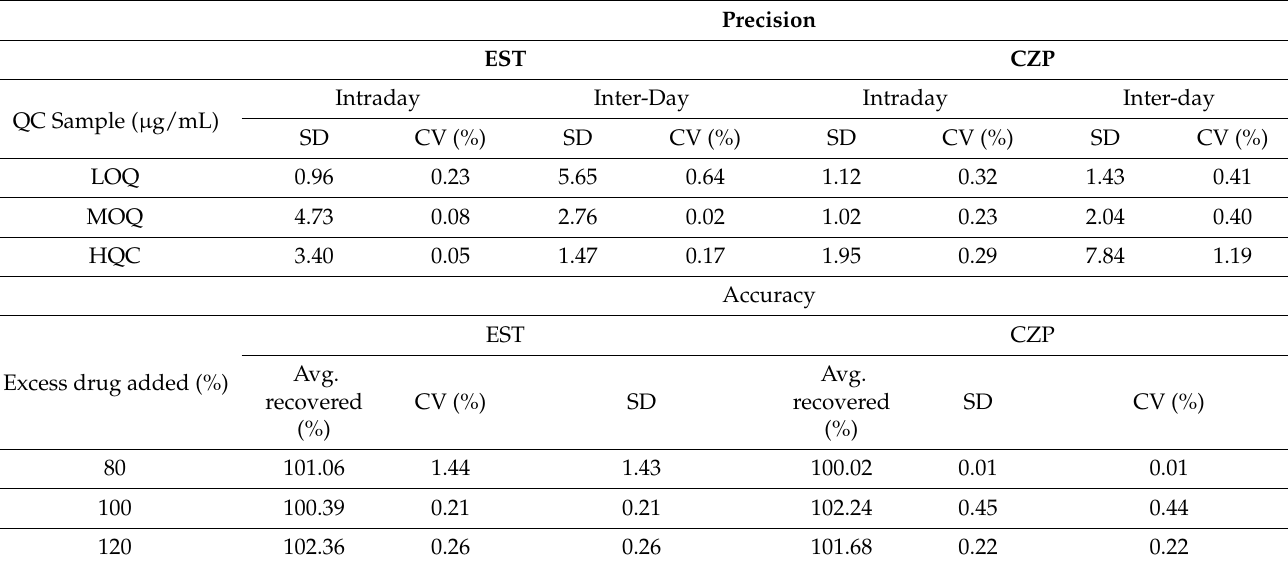
Table 3. Precision and accuracy